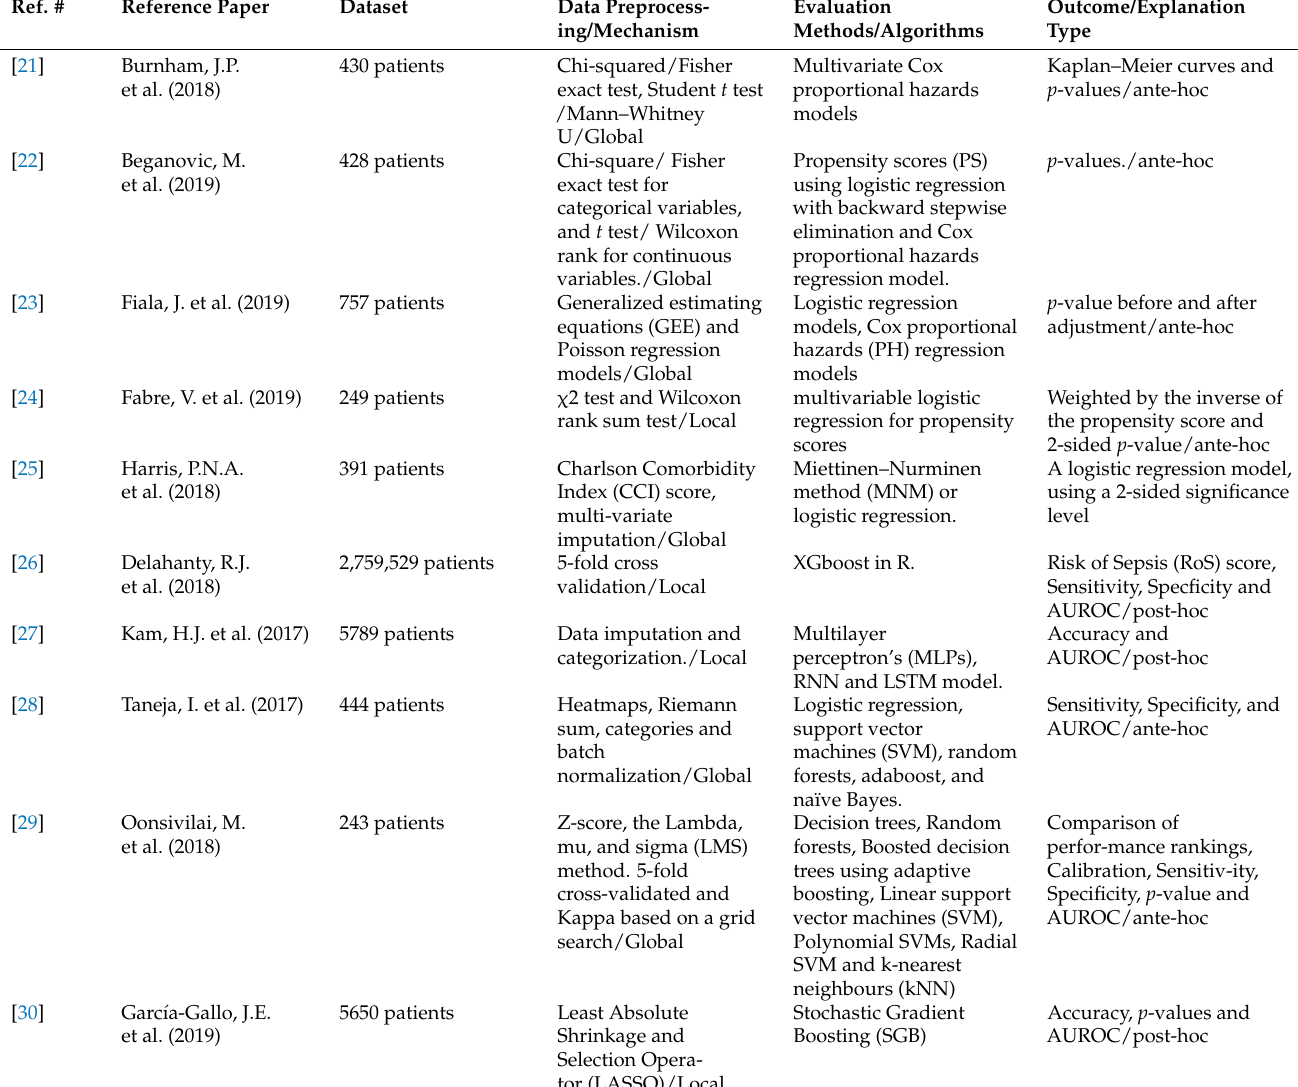
Table 2. Analysis for the BSI-affected patients treatment